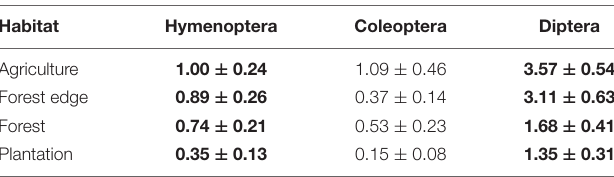
TABLE 1 | Average values of major pollinator abundances (blue, yellow, and white traps combined) in the four habitat types. Habitat Hymenoptera Coleoptera